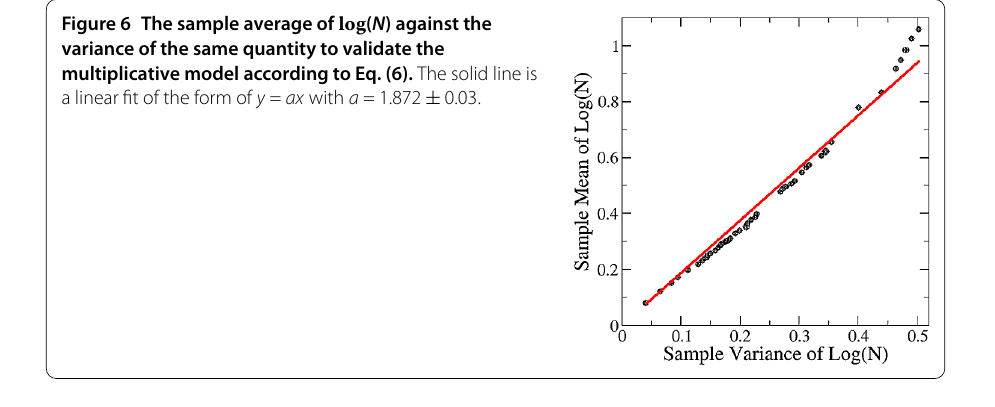
Figure 6 The sample average of log ( N ) against the variance of the same quantity to validate the multiplicative model according to Eq. (6). The solid line is a linear fit of the form of y = ax with a = 1.872 ±